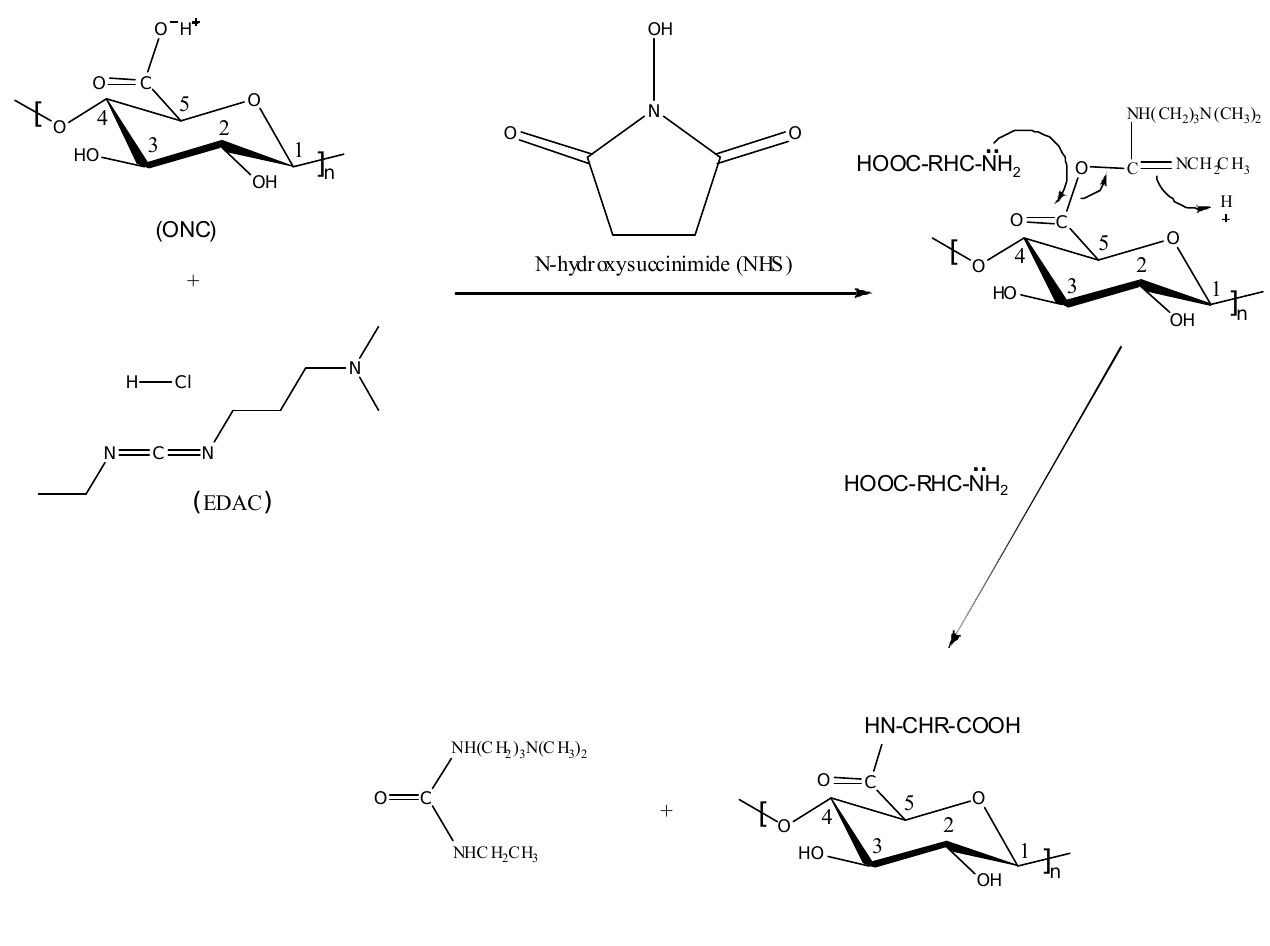
Scheme 1. Illustration of the coupling mechanism between oxidized nanocellulose (ONC) N–CHR–COOH, where R is an organic and an amino acid (H 2